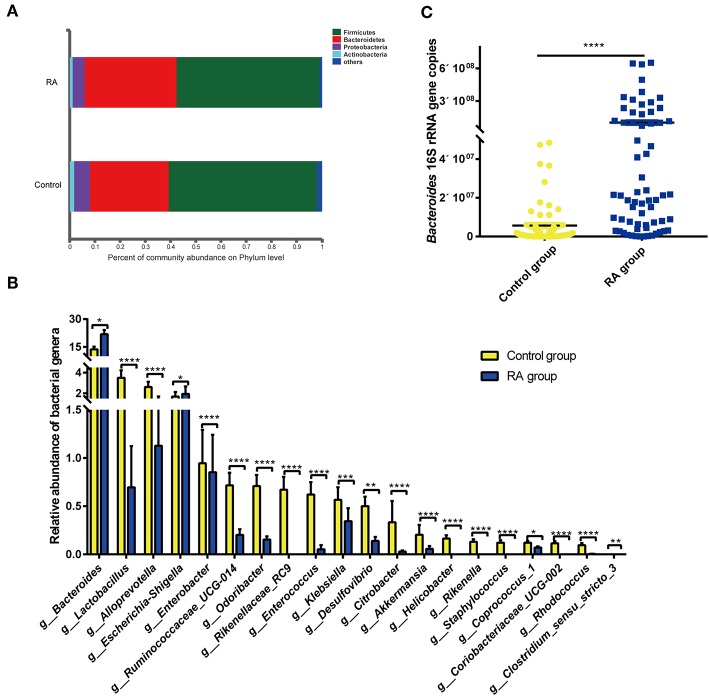
Differences in composition of the gut microbiome between the RA group and control group. (A) Prevalence of bacterial phyla. (B) Compositions of specific bacterial genera with the highest abundances in the RA and control cohorts. (C) qRT-PCR analysis of Bacteroides 16S rRNA genes. *p < 0.05, **p < 0.01, ***p < 0.001, ****p < 0.0001.